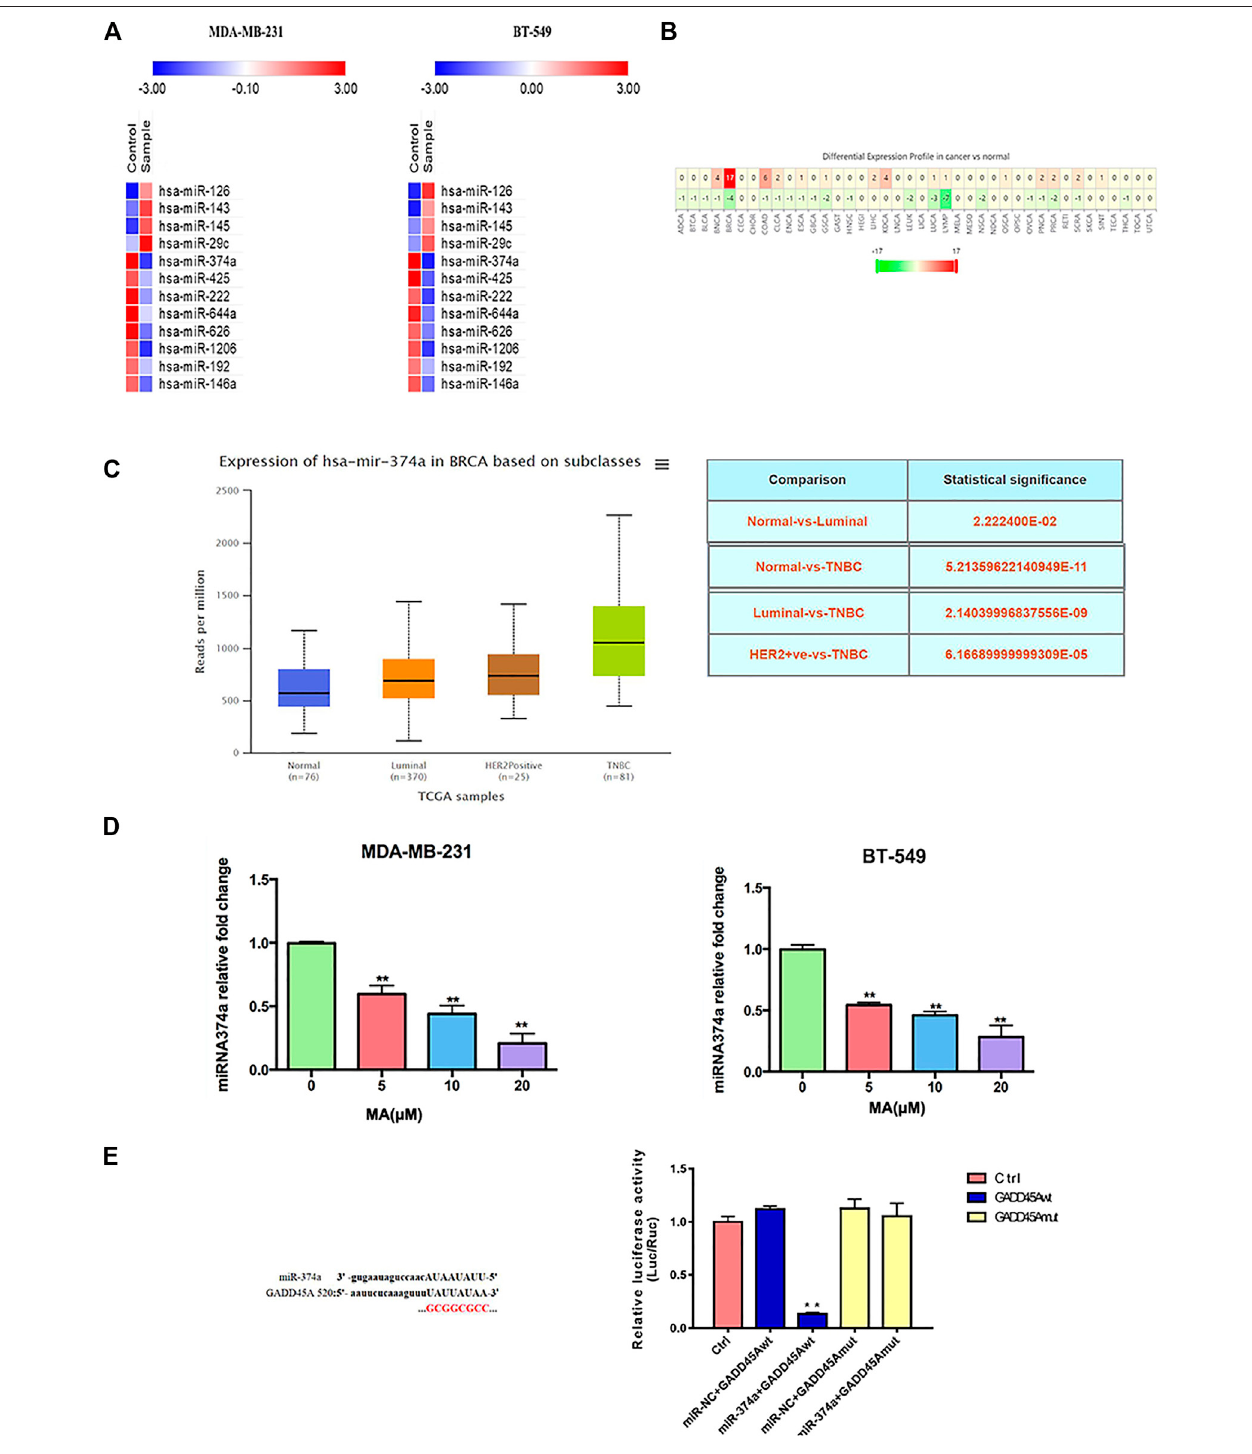
FIGURE 6 | Overexpressed miR-374a is inhibited by MA in TNBC cells. (A) PCR array analysis of miRNAs variation in TNBC cells after 24 h MA intervention. (B) MiR-374a expression in different types of cancer tissues and the corresponding normal tissues. (C) MiR-374a expression in different types of breast cancer tissues and normal tissues. (D) Real-time PCR analysis of miR-374a expression in TNBC cells after 24 h MA intervention. (E) Relative luciferase activity determined through dual luciferase reporter assay in 293 T cells. Compared to the control group, ** p < 0.01.